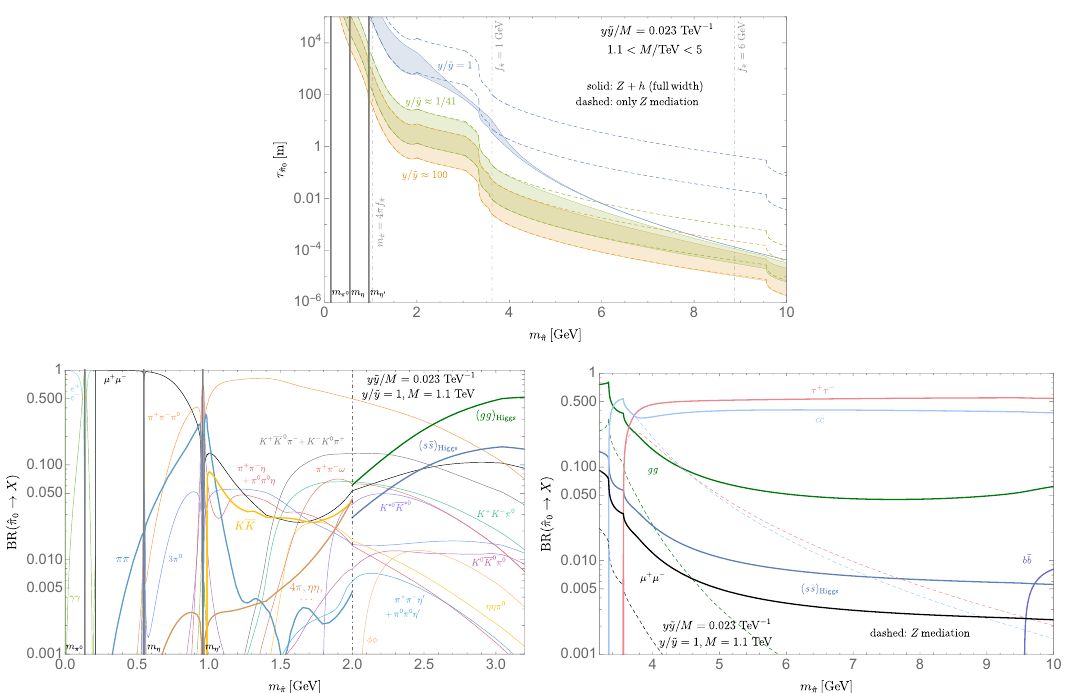
Figure 4 . (Top) lifetime of ˆ π 0 for exact dark U(1) . We have set y ˜ y/M to saturate the h → invisible bound, while f is fixed by eq. (4.13) as a function of m (representative values are indicated by ˆ π ˆ π vertical dot-dashed lines). Filled bands display the full width varying 1 . 1 < M/ TeV < 5 , for three values of r = y/ ˜ y , where r ≈ 100 and r ≈ 1 / 41 are chosen to saturate the Z → invisible bound for M = 1 . 1 TeV. Dashed curves indicate the same, but including only the Z -mediated contribution to the width. (Bottom) ˆ π branching ratios for r = 1 , M = 1 . 1 TeV, and y ˜ y/M saturating the 0 h → invisible bound. In the left panel, the hadronic channels mediated by Higgs exchange are indicated by thicker curves. For γγ , e + e − and µ + µ − the Z - and h -exchange contributions were summed. The vertical dot-dashed line indicates m = 2 GeV, where the description of CP -even ˆ π decays transitions from exclusive hadronic final states to a perturbative spectator model. In the right panel, dashed curves show the contribution to the BRs of the Z -mediated